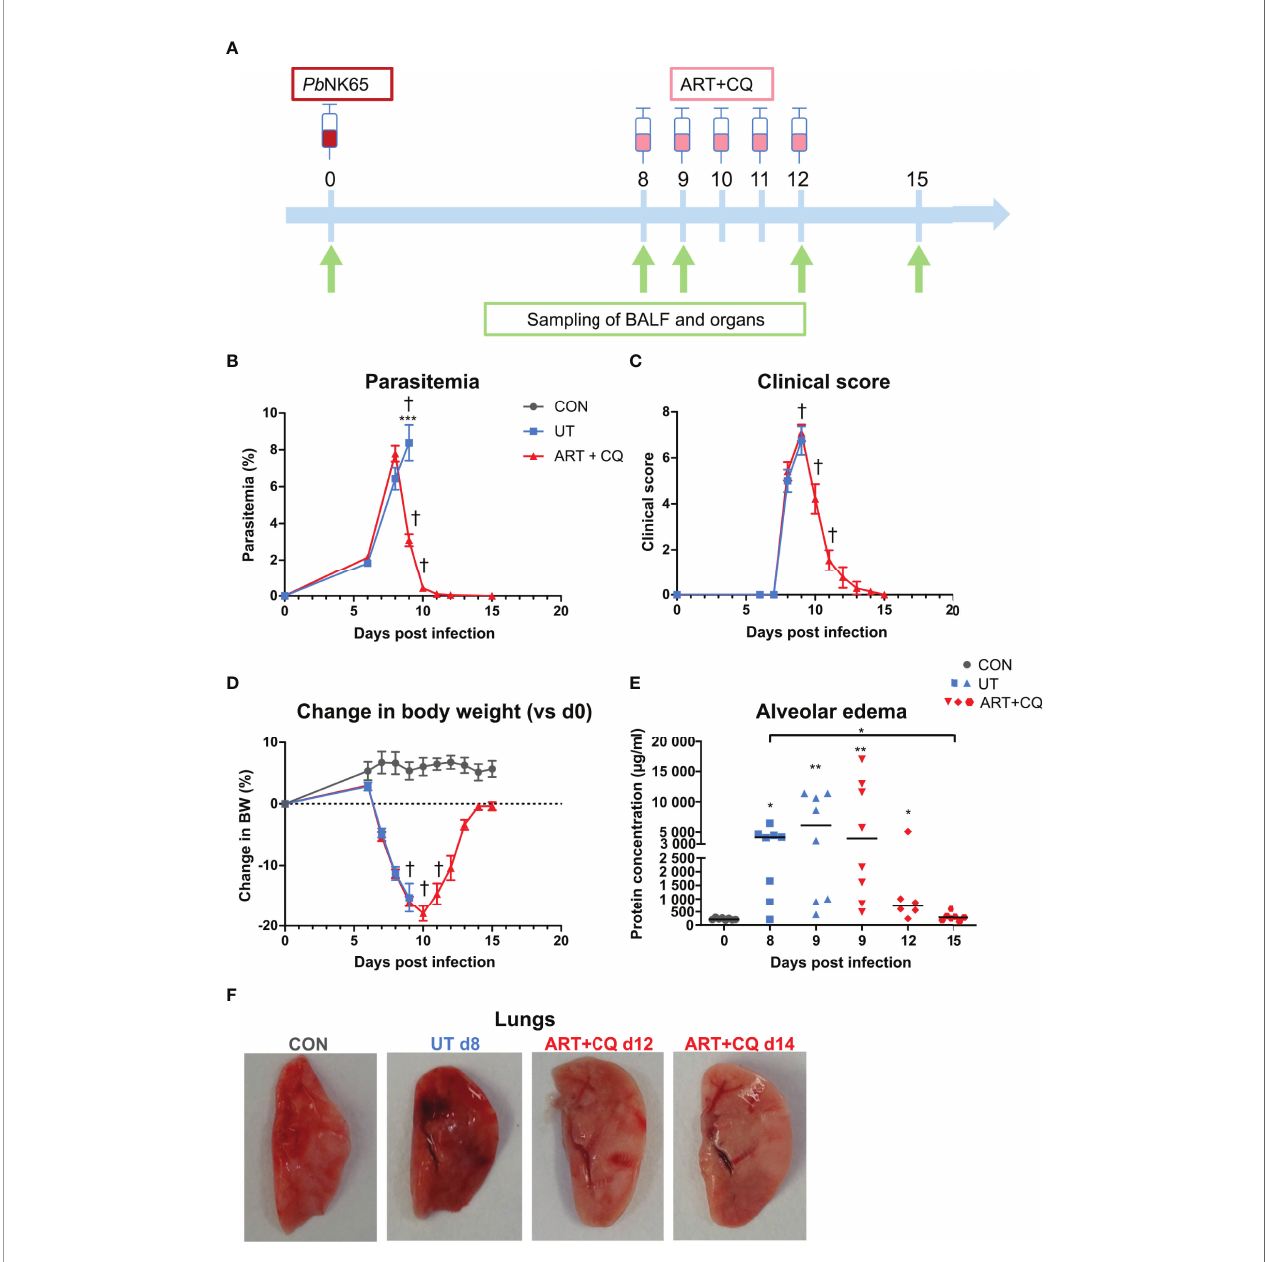
FIGURE 1 | A mouse model to study the resolution of malaria-associated acute respiratory distress syndrome (MA-ARDS) after antimalarial treatment. C57BL/6 mice were infected with Pb NK65. Mice were injected daily from 8 until 12 days p.i. with 10 mg/kg ART + 30 mg/kg CQ (ART+CQ). (A) Schematic representation of the timing of infection and antimalarial treatments in the mouse model. (B) Parasitemia was determined using Giemsa-stained blood smears. (C) The clinical score was monitored daily starting at 6 days p.i. (D) The change in body weight was calculated compared to day 0 p.i. starting at 6 days p.i. (B, D) Compilation of two experiments. Data are means ± SEM. n=8 for uninfected controls (CON), n=8 – 16 for the infected untreated group (UT), n=7 – 21 for the infected ART+CQ-treated group. (E) The protein concentration in the BALF was determined as a measure of alveolar edema. Compilation of two experiments. Each symbol represents data of an individual mouse. n=8 for CON on day 0, UT at 8 and 9 days p.i and ART+CQ at 9 days p.i., n=6 for ART+CQ at 12 days p.i., n=7 for ART+CQ at 15 days p.i. (F) Representative pictures of the left